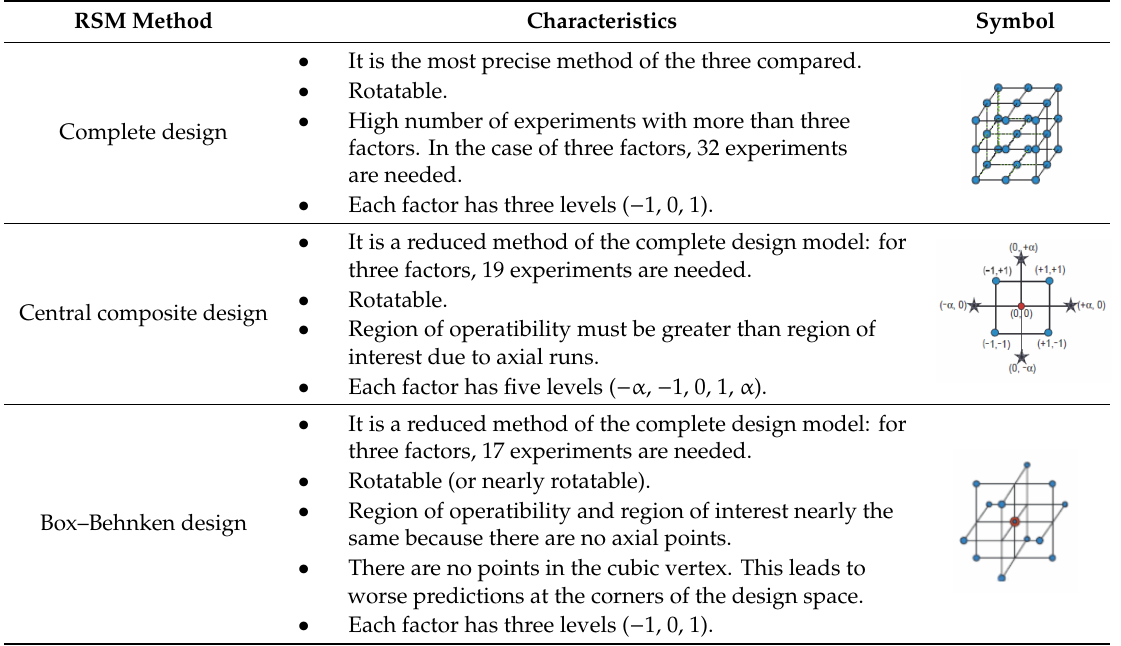
Table 2. Main characteristics of the three response surface methodology (RSM) methods used for optimisation in this